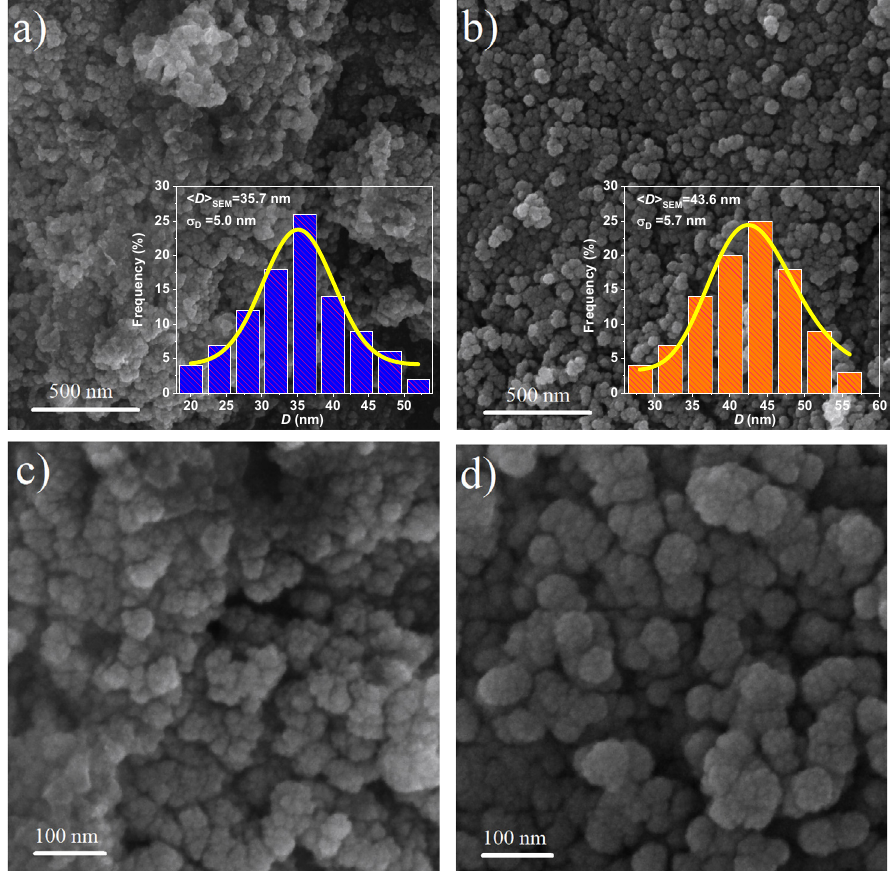
Fig. 4. FE-SEM image of (a) Fe fitted by a log-normal function. Image at the higher magnification of 330 kx for (c) Fe